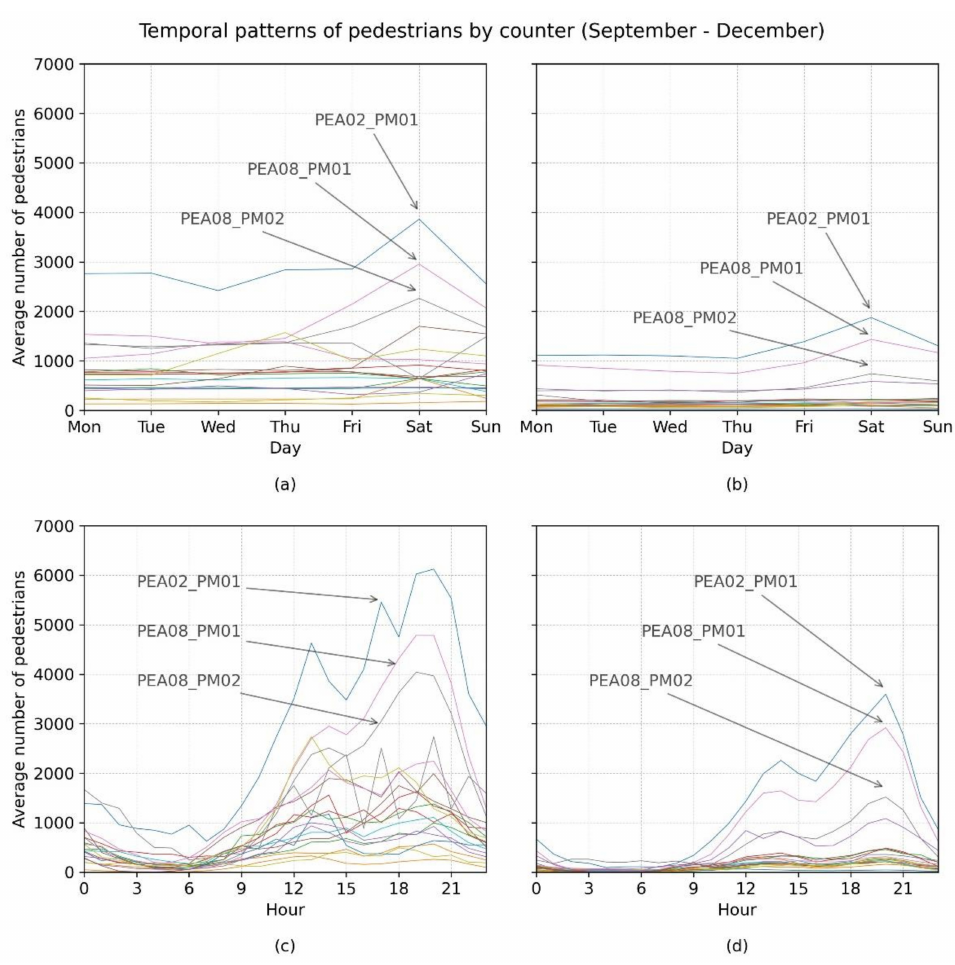
Figure 7. Temporal patterns by counter ( a ) day of week 2019, ( b ) day of week 2020, ( c ) time of day 2019, ( d ) time of day